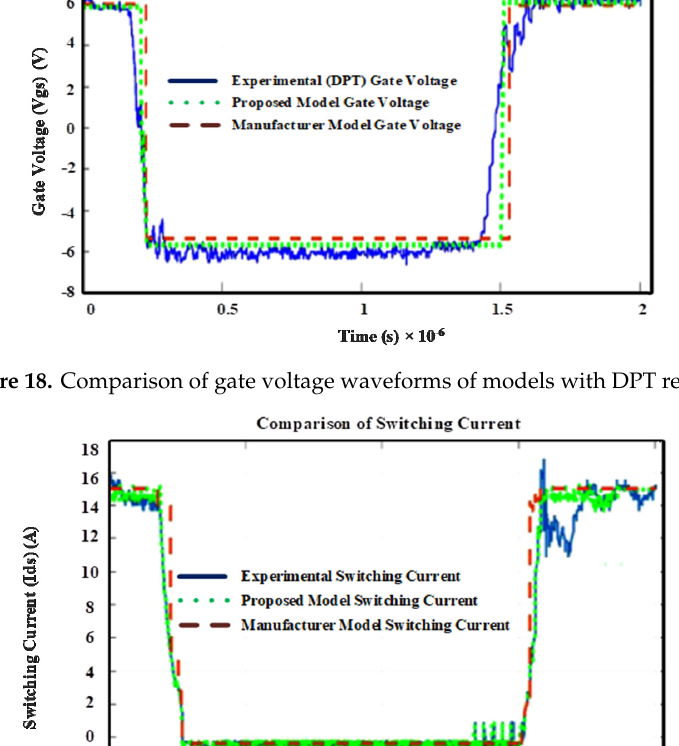
Figure 18. Comparison of gate voltage waveforms of models with DPT results.